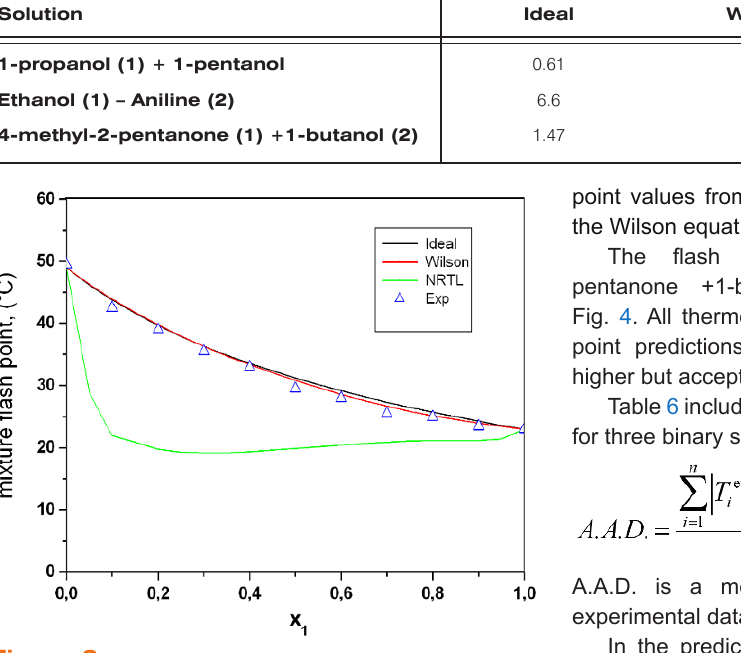
Figure 3. Comparison of the flash point prediction curves with experimentally derived data for Ethanol (1) – Aniline (2).